Question: Briefly state, in one sentence, what is plotted here.
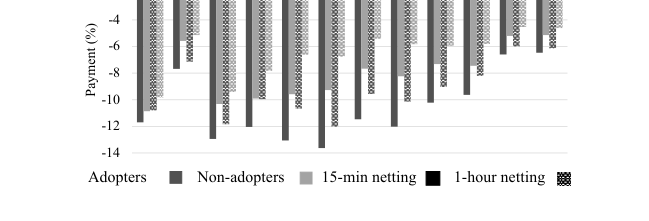
Answer: shows the surplus (top) and payment (bottom) gains (%) of DG adopters and non-adopters over their benchmark after joining community 1. Both classes beneﬁted from joining the community by having higher surpluses and lower pay- ments. However, adopters beneﬁted more from the community as they more often operate in net consumption zones different than the community. Congruent with Fig.3, households bene- ﬁted more from the community when the netting was faster.